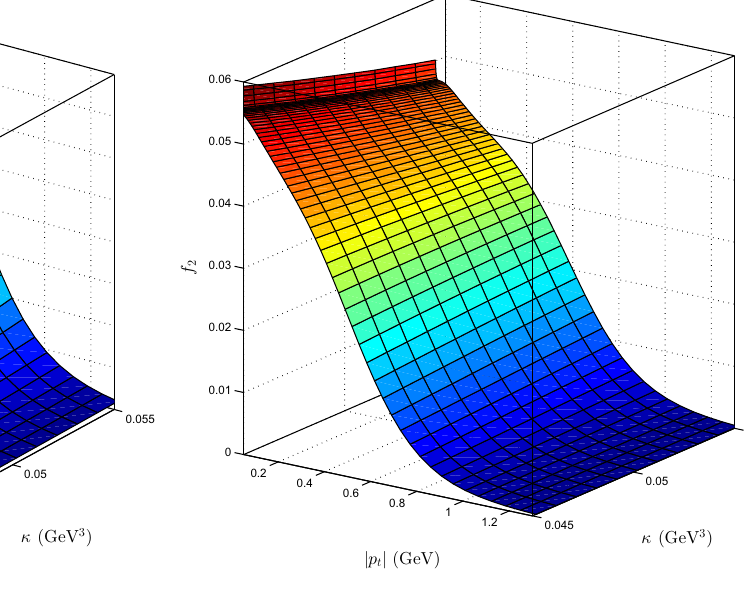
Fig. 2 The BS wave functions for the